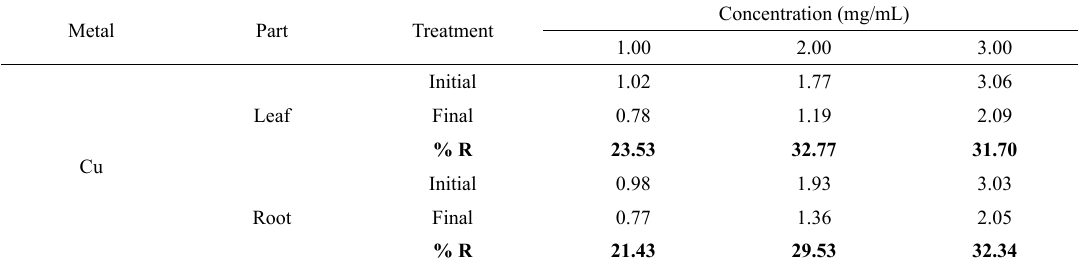
Table 2. Metal removal percentage copper concentrations in the initial and final treatments of the leaf and root